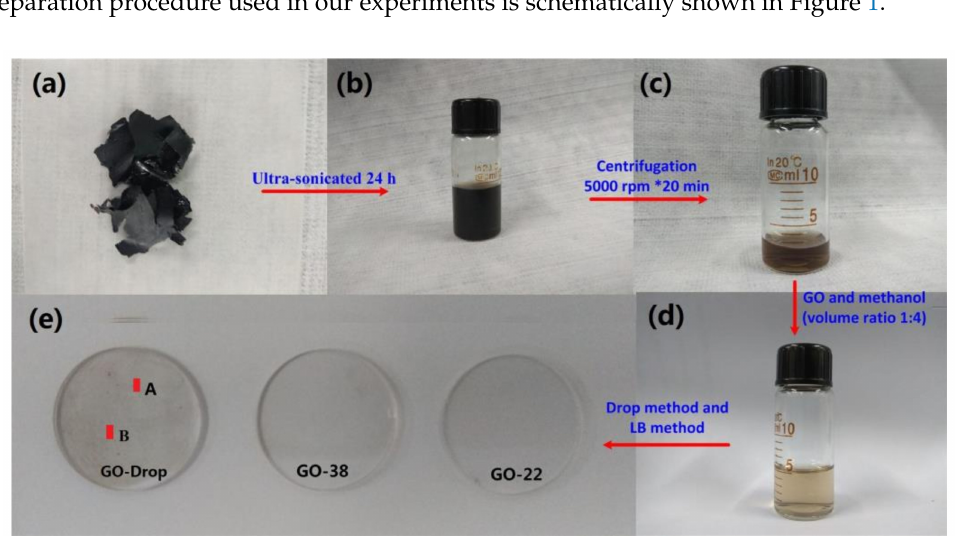
Figure 1. Preparation steps of graphene oxide (GO) solution: ( a ) GO slices, ultrasonicated ( b ) and centrifuged ( c ) GO solution, ( d ) GO dispersion of Langmuir-Blodgett (LB) in methanol, and ( e )